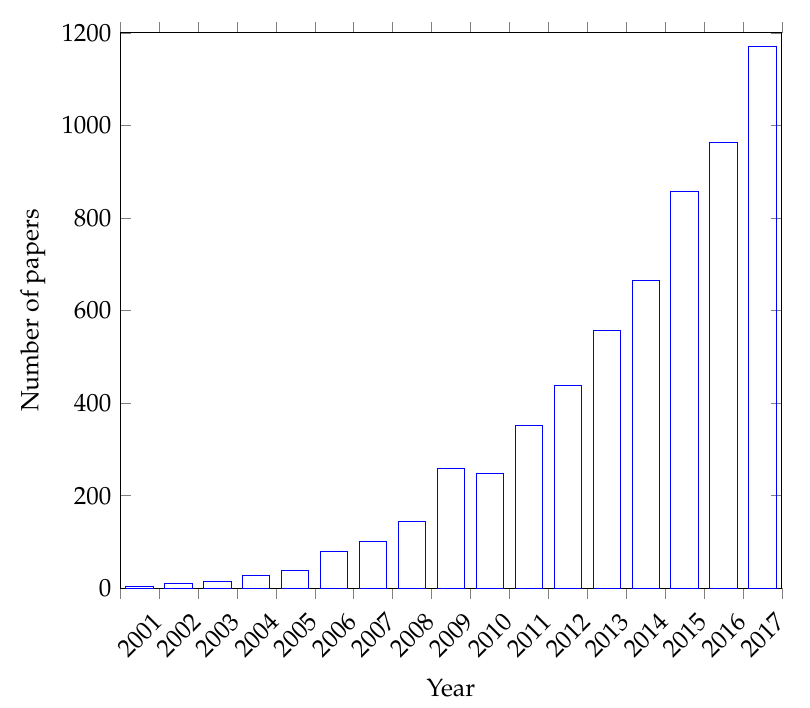
Figure 4. Hits for query (“swarm intelligence” AND “feature selection”) in Google